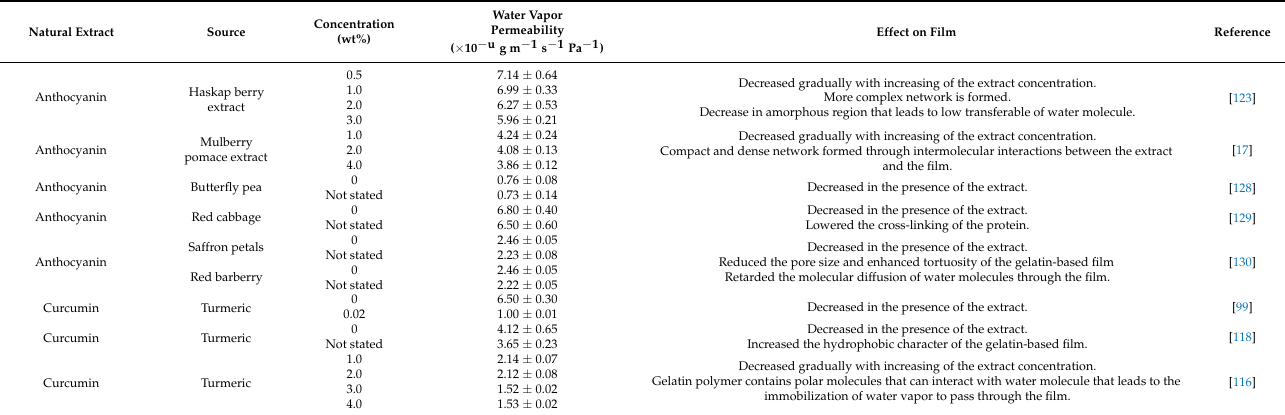
Table 4. Relationship between the concentration of natural extract and water-vapor permeability of gelatin-based